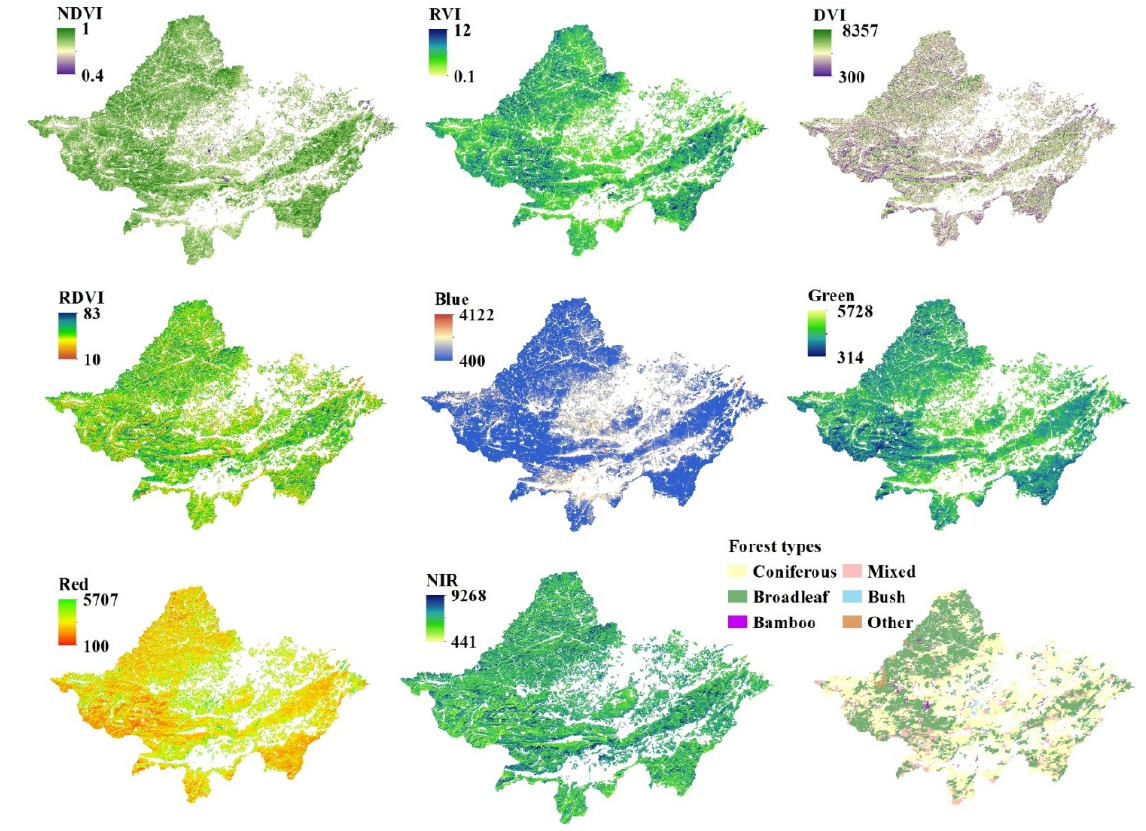
Figure 2. Nine remote sensing variable images derived from GF-1.